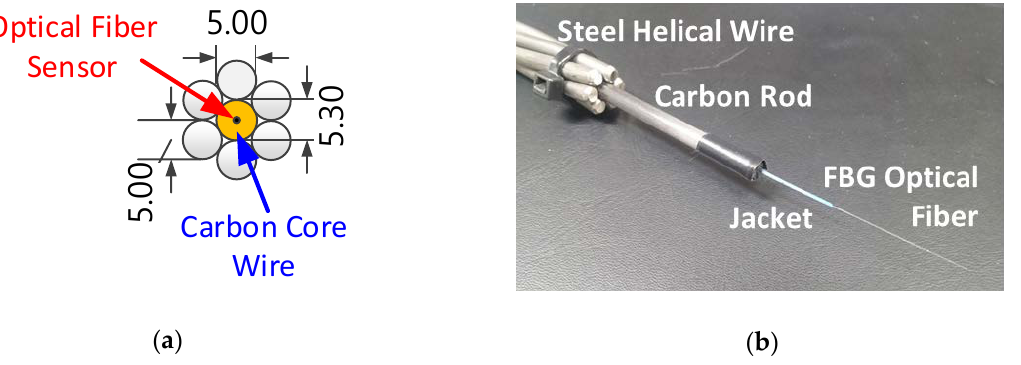
Figure 3. Optical sensor PC (OSPC) strand: ( a ) Conceptual drawing; ( b ) Actually manufactured product.